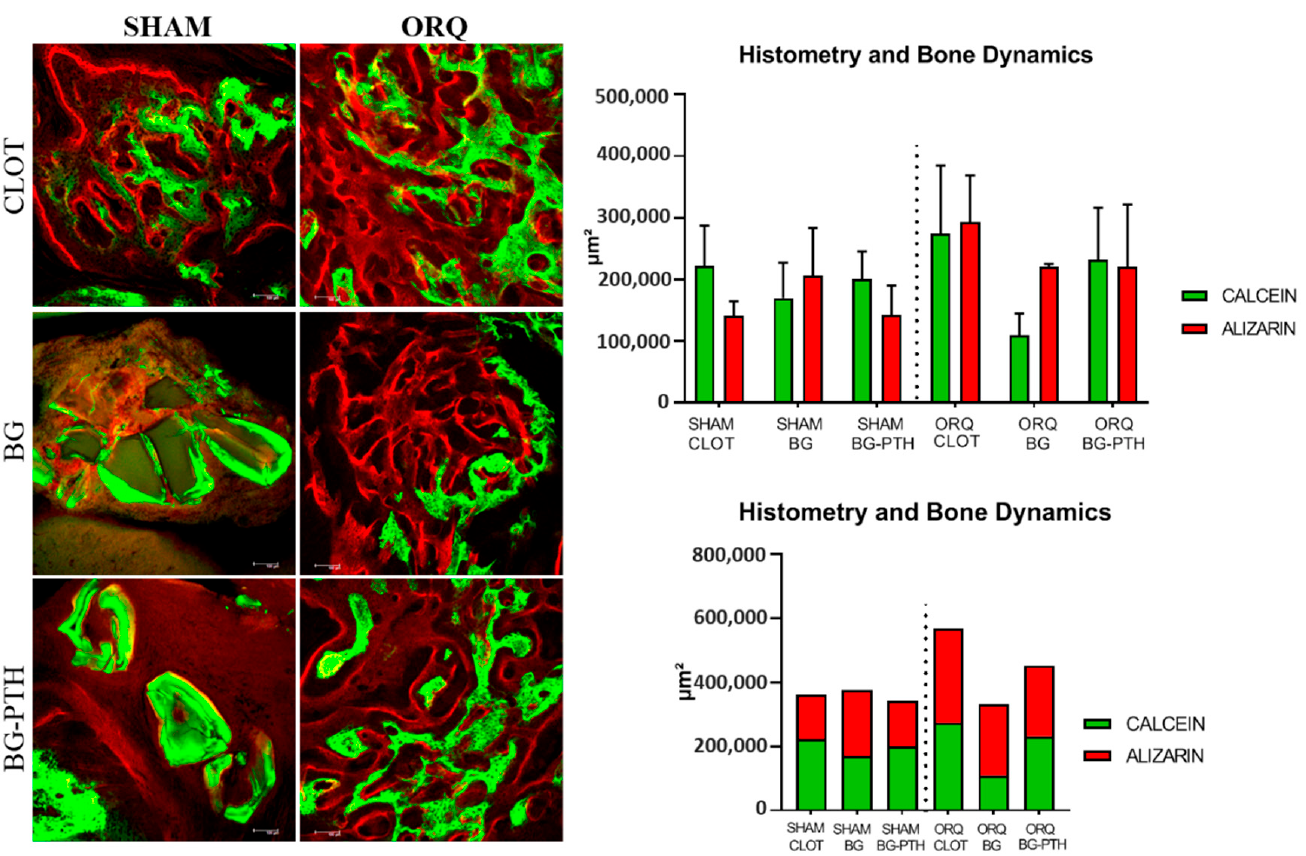
Figure 4. Confocal microscopy analysis the fluorescent areas in the calcium matrix by overlap of calcein (green) and alizarin (red). Graphic representation of the bone dynamics of the experimental groups: SHAM and ORQ (CLOT, BG and BG-PTH). The statistical difference can be seen in Table 3. Table 3. Representation of bone dynamics: calcein vs. alizarin; calcein vs. calcein and alizarin vs. alizarin to represent the statistical difference between all groups SHAM vs. ORQ (CLOT, BG and BG-PTH), indicate significance at p < 0.05.